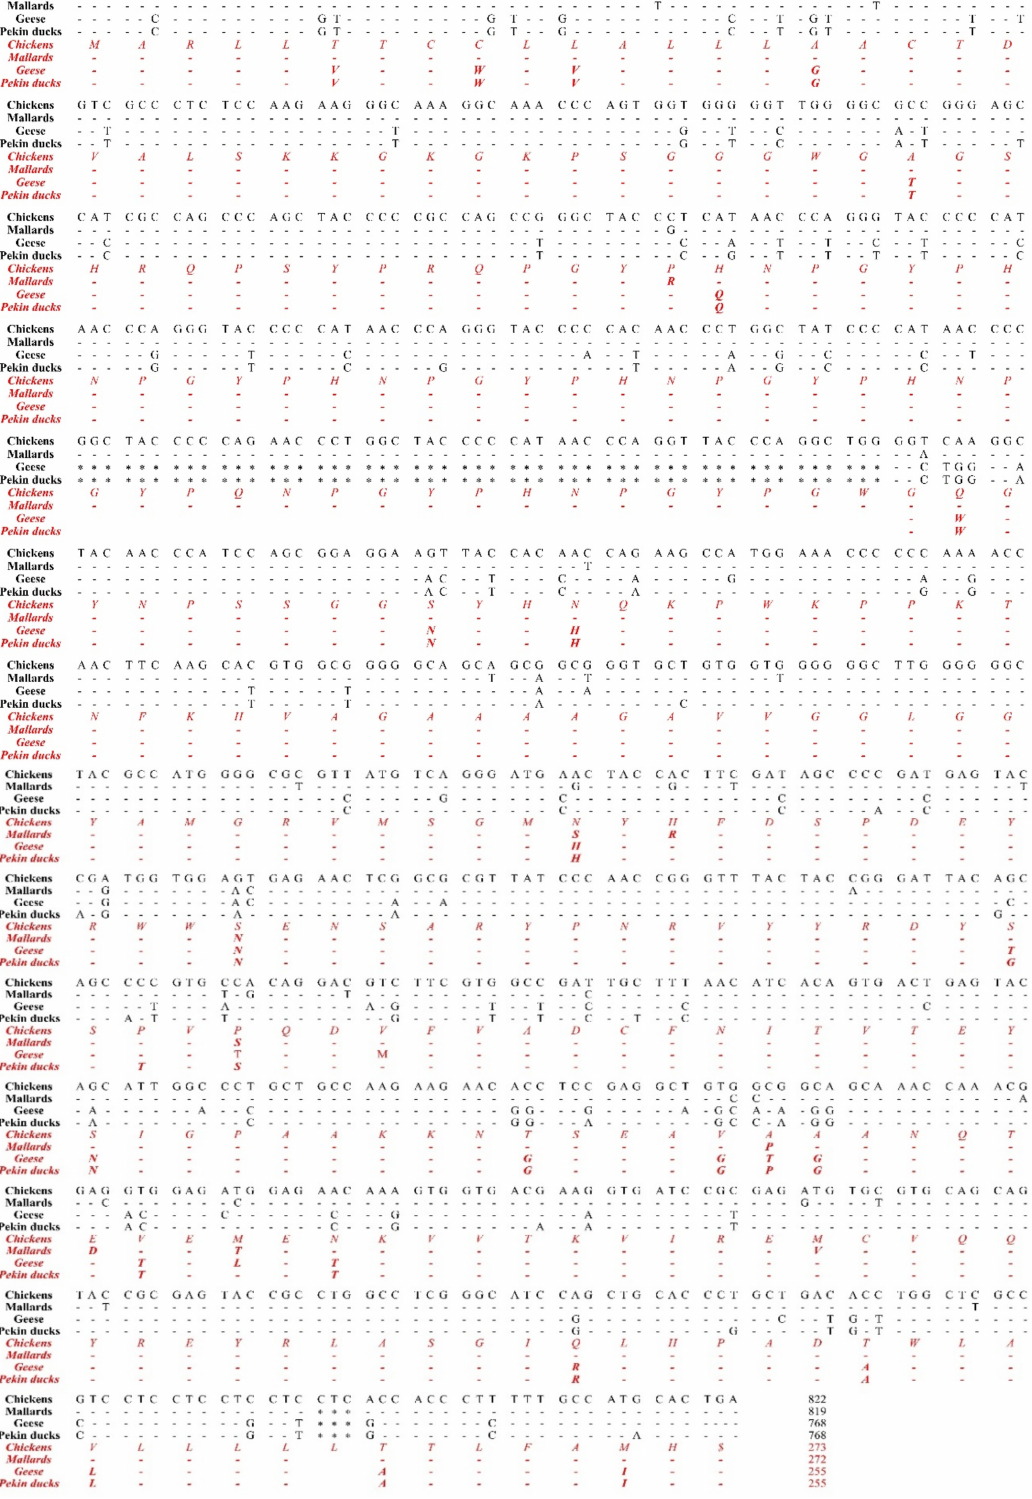
Figure 1. The comparison of the ORF of the PRNP gene was performed in chickens, mallards, geese, and Pekin ducks. The black text indicates nucleotide sequences and the red and italic texts indicate amino acid sequences. -, identical nucleotide or amino acid to chicken; *, nucleotide deletion; $, stop